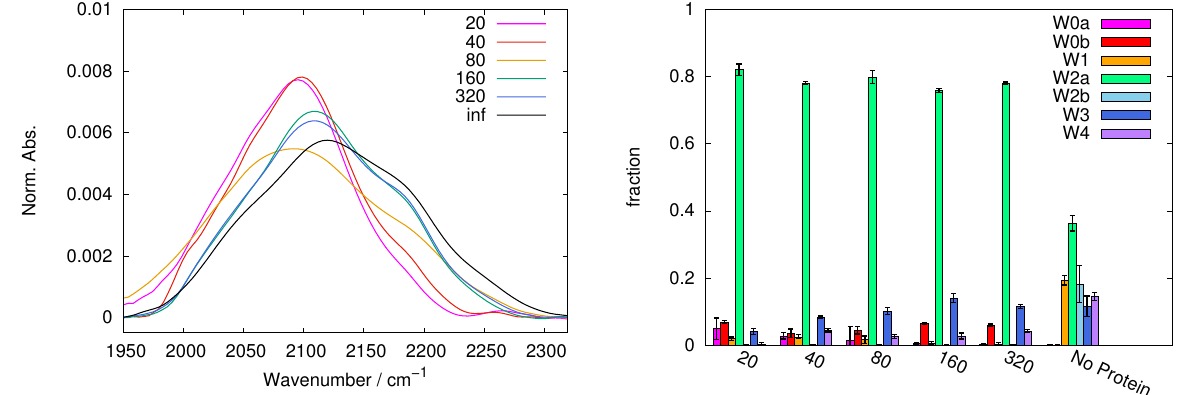
Figure 5. As for Figure 1, in protein + raffinose matrices. Here the WAB behavior looks like the sucrose one. However two distinct steps are evident: between S/P = 40 and 80 and between 80 and 160. In any event, as in the case of sucrose, the W2a bulk like sub-band is dominant at all